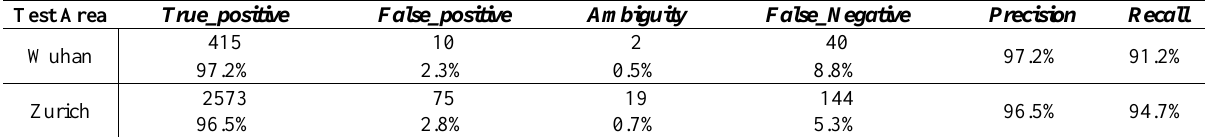
Table 1. The statistical matching results according to the proposed